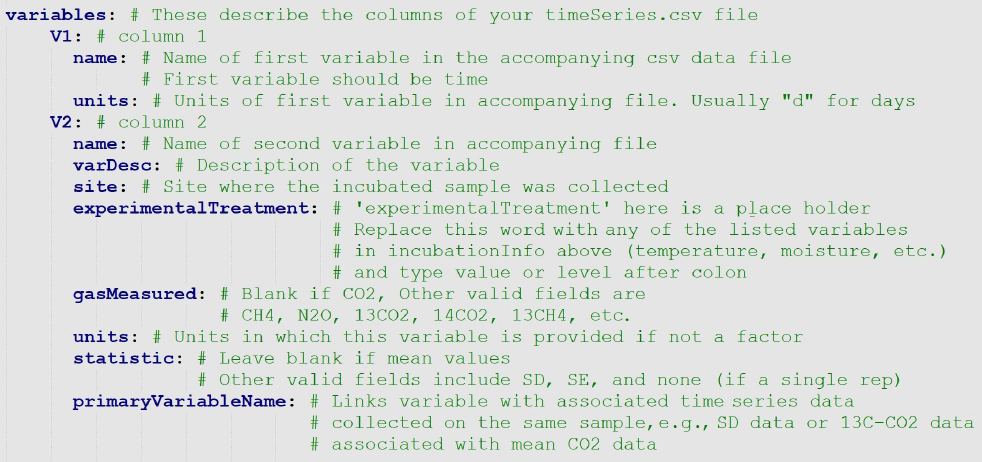
Figure 5. Information for each